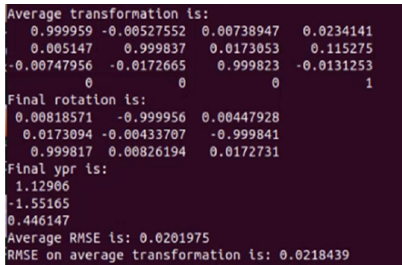
Figure 12. Results of using two calibration plates.